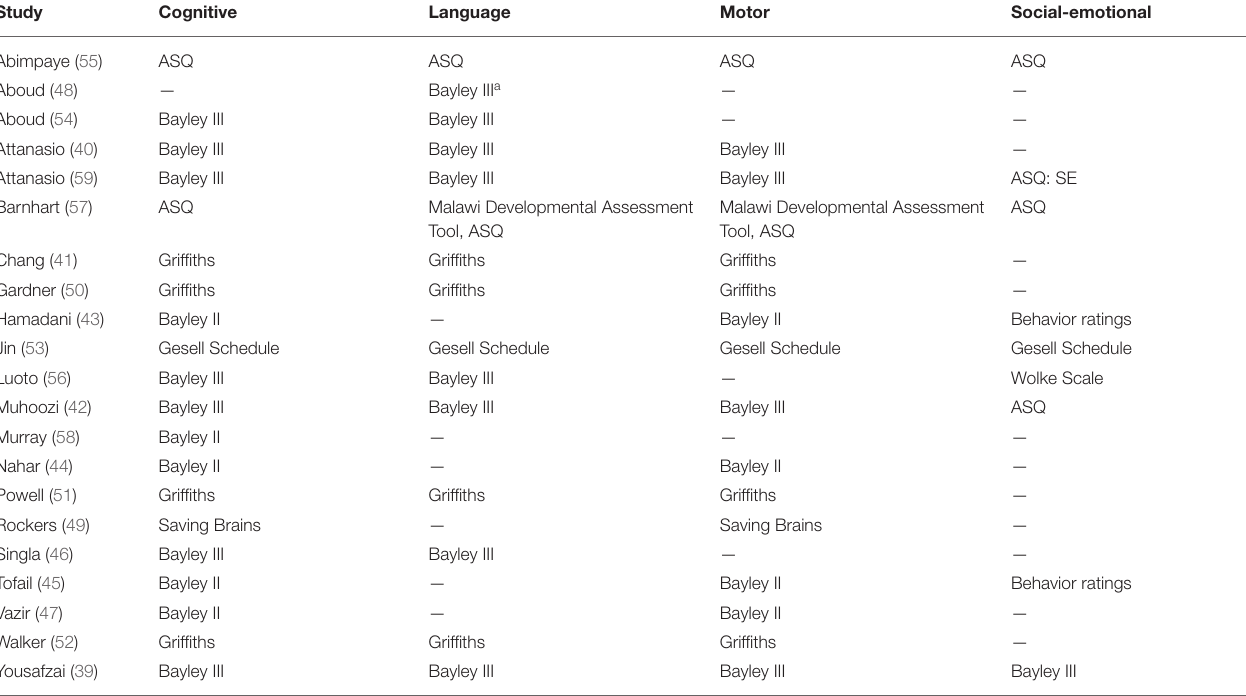
TABLE 2 | Assessment tools for developmental outcomes. Study